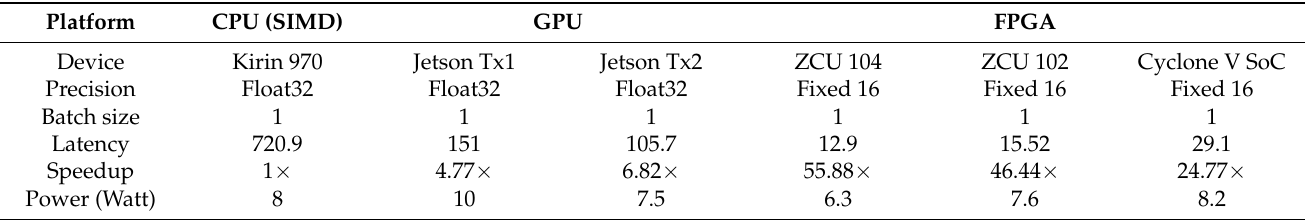
Table 5. Comparison with CPU/GPU edge